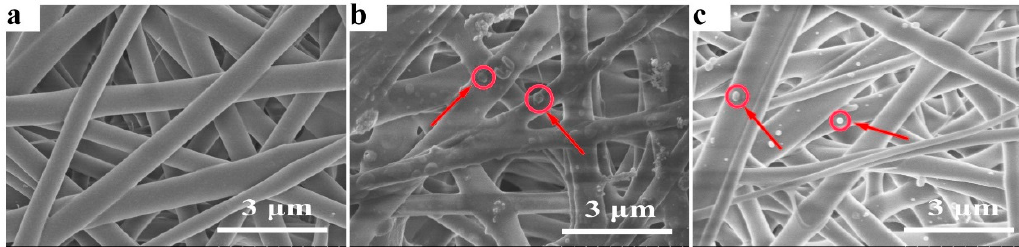
Figure 1. SEM micrographs of electrospun fibrous meshes: ( a ) PCL-PIBMD meshes; ( b ) PCL-PIBMD/MPs meshes; and ( c ) PCL-PIBMD/MPs-pZNF580 meshes. MPs and MPs-pZNF580 were marked by red circles and arrows.